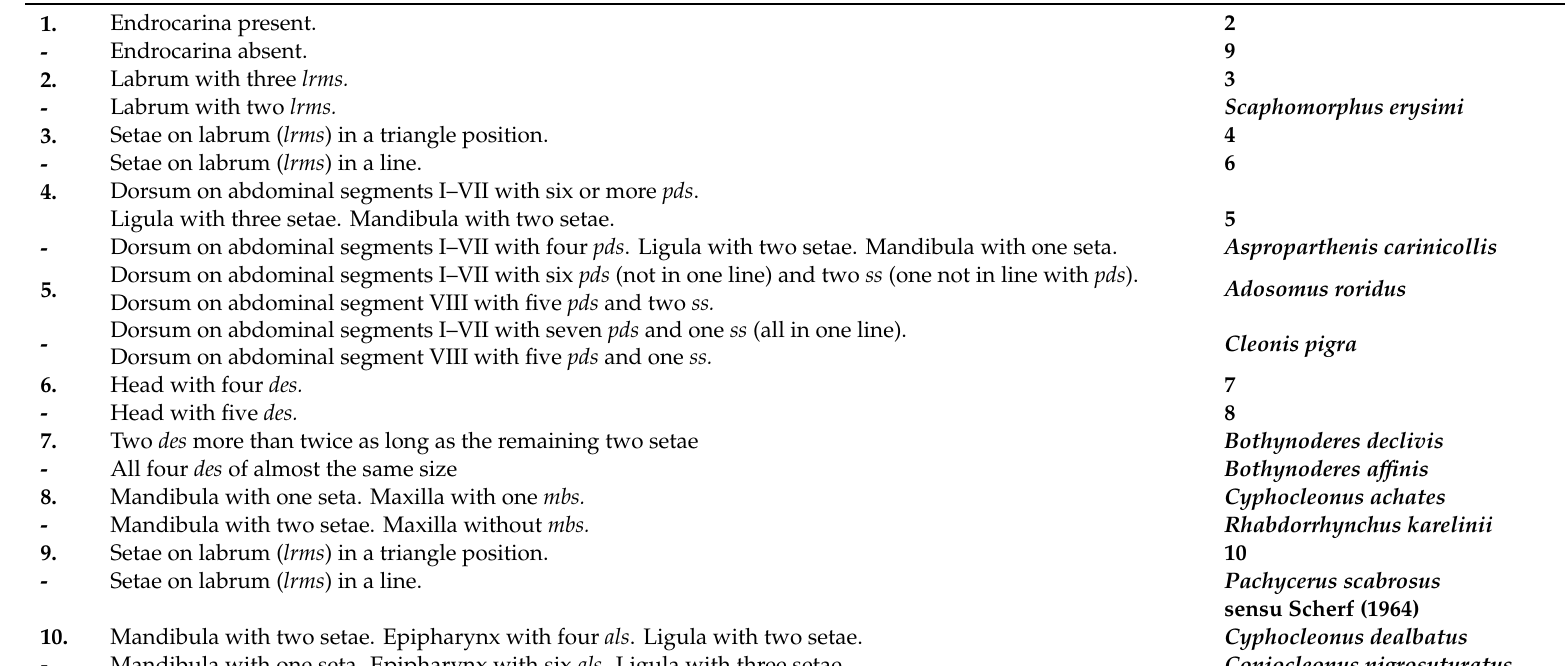
Table 1. Key to the Known Larvae of